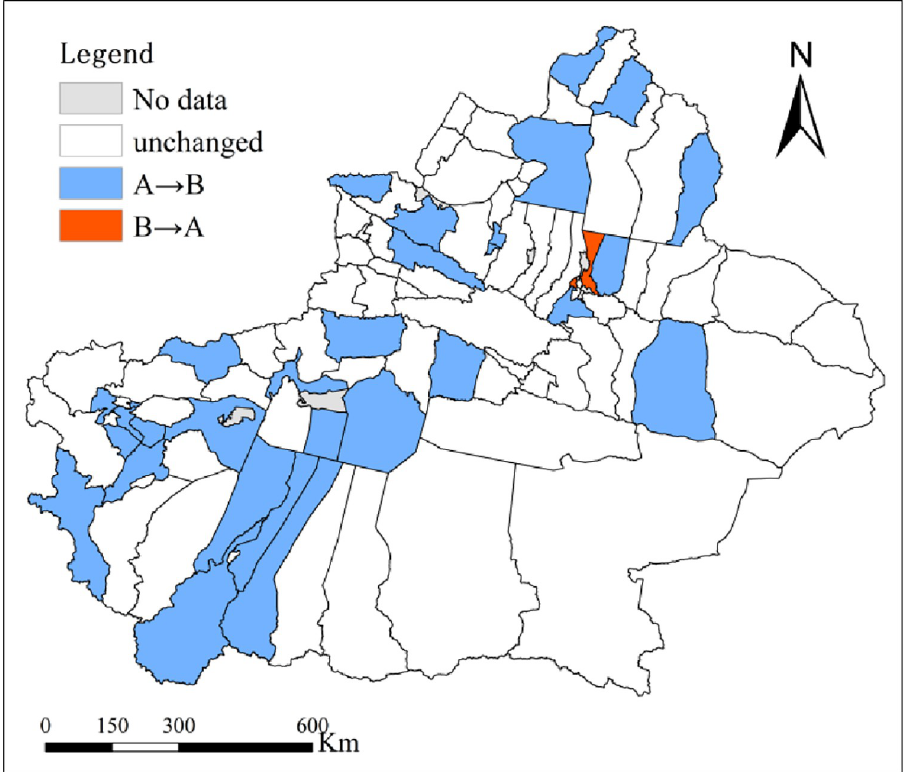
Fig 9. Comparison and visualized analysis for the number of counties and cities by EDI and EDI with EC corrected.